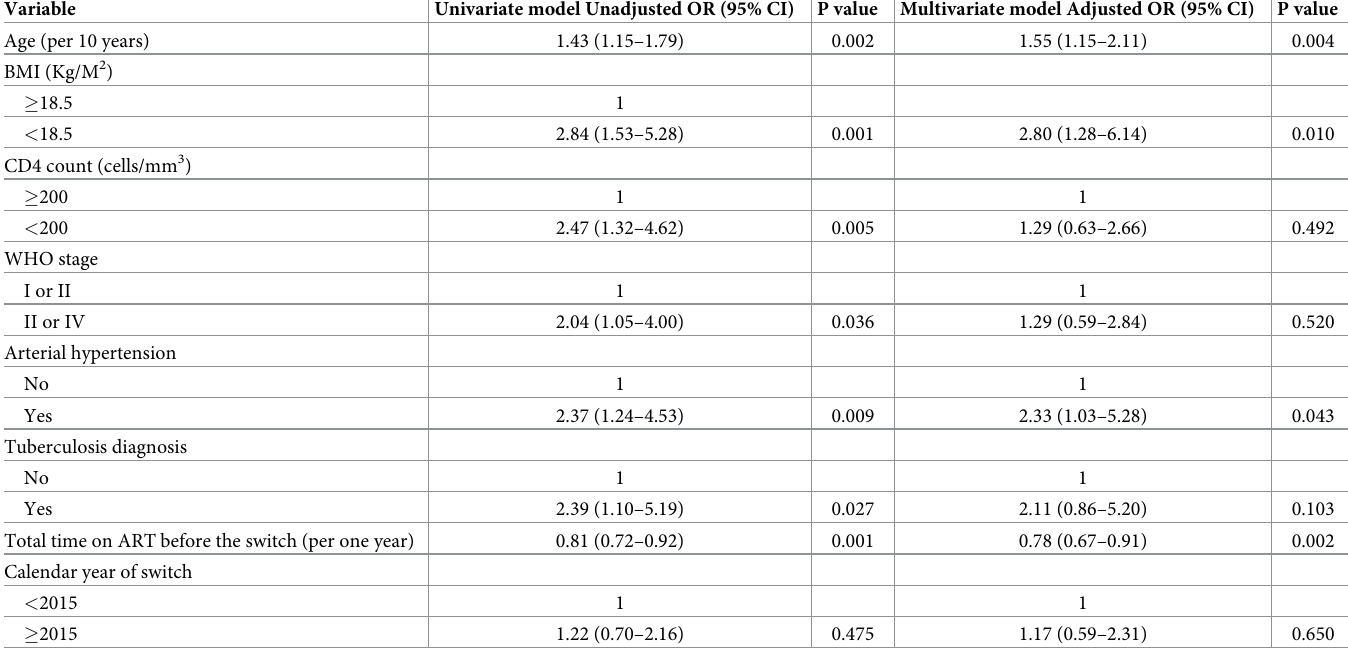
Table 2. Univariate and multivariate logistic regression model for predictors of renal impairment at switch to second line ART (n = 687).